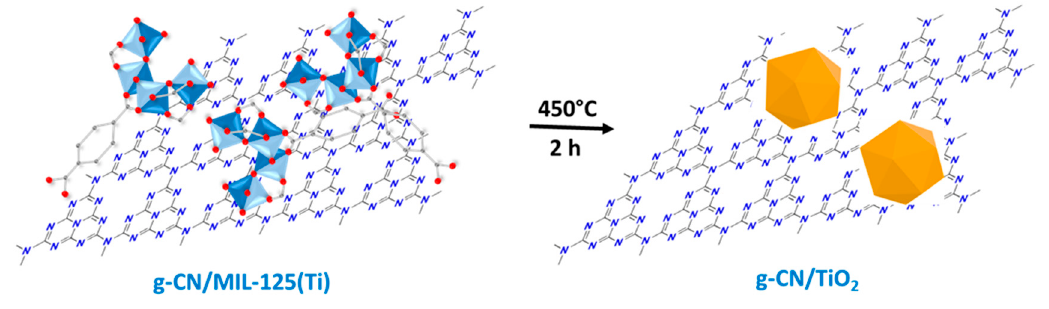
Figure 1. Schematic illustration of the preparation of the graphitic carbon nitride (g-CN) / TiO 2 photocatalysts from g-CN / MIL-125(Ti) composites.